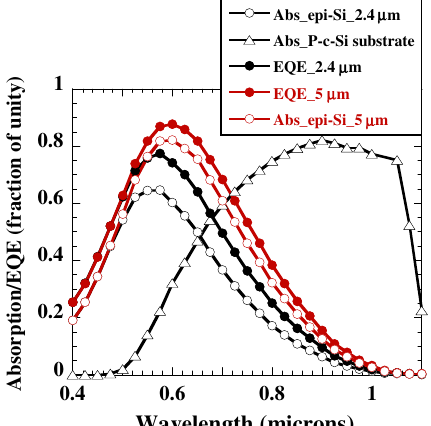
Fig. 4. Model calculations of the absorption (Abs) in the 2.4 μ m epitaxial silicon (epi-Si) layer and the P-type c-Si sub- strate (black lines with open circles and open triangles respec- tively) and the external quantum efficiency (EQE – black line with closed circles) of the 2.4 μ m cell. Also shown are the cal- culated values of the absorption in the epi-Si layer (red line with open circles) and the EQE (red line with closed circles) if the epi-Si layer were to be 5 μ m